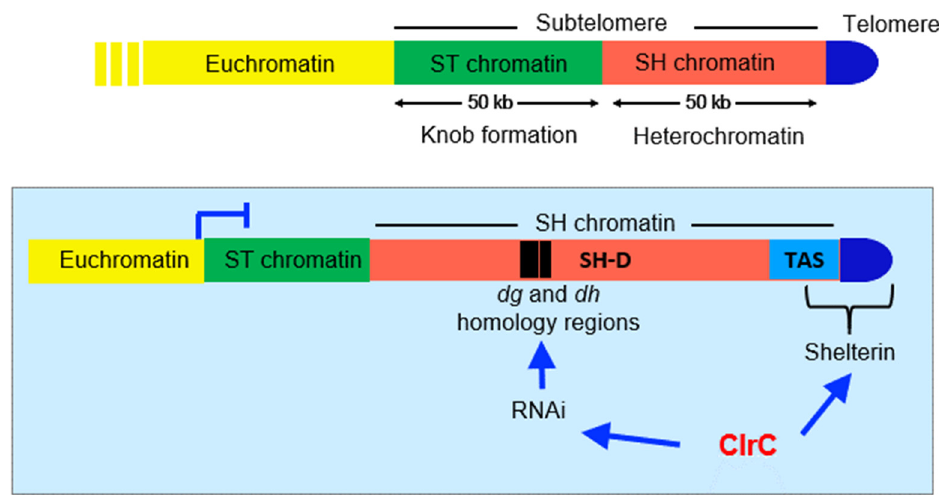
Figure 3. Subtelomeric domains in S. pombe , with a focus on SH domains, which consist of telomere-associated sequences (TAS) and SH-D domains on which heterochromatin assembles. Shelterin complex binds the telomere and TAS sequences and RNAi activity is directed through the dg and dh homology sequences resident within SH-D.